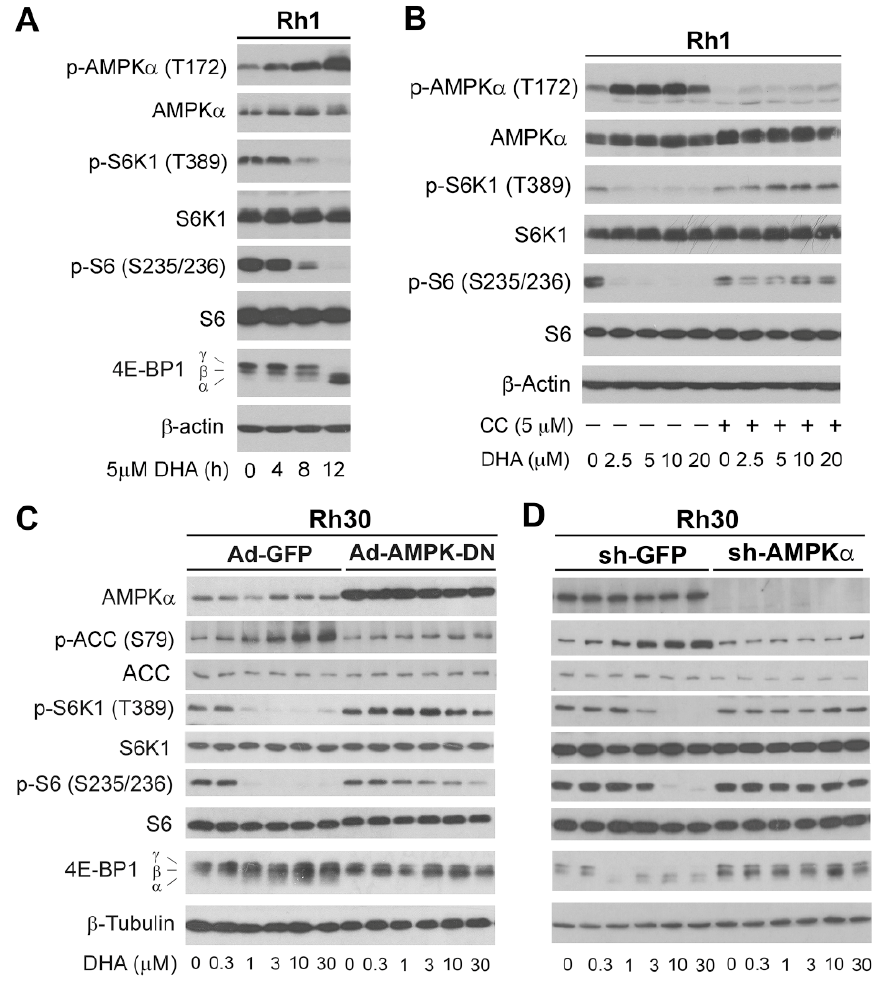
Figure 7. DHA-induced activation of AMPK contributes to inhibition of mTORC1. ( A ) Rh1 cells were treated with DHA (5 μ M) for indicated time, followed by Western blotting with indicated antibodies. ( B ) Rh1 cells were pretreated with or without Compound C (CC) (5 μ M) for 2 h, and then exposed to with or without DHA (5 μ M) for 24 h, followed by Western blotting using indicated antibodies. ( C ) Rh30 cells were infected with recombinant adenovirus expressing myc-tagged dominant negative (DN) AMPK (Ad-AMPK-DN) or GFP (Ad-GFP) for 24 h, and then treated with DHA (0 − 30 μ M) for another 24 h, followed by Western blotting with indicated antibodies. ( D ) Rh30 cells, infected with lentiviral shRNA to human AMPK α 1 or GFP, were treated with DHA (0 − 30 μ M) for 24 h, followed by Western blotting with indicated antibodies.